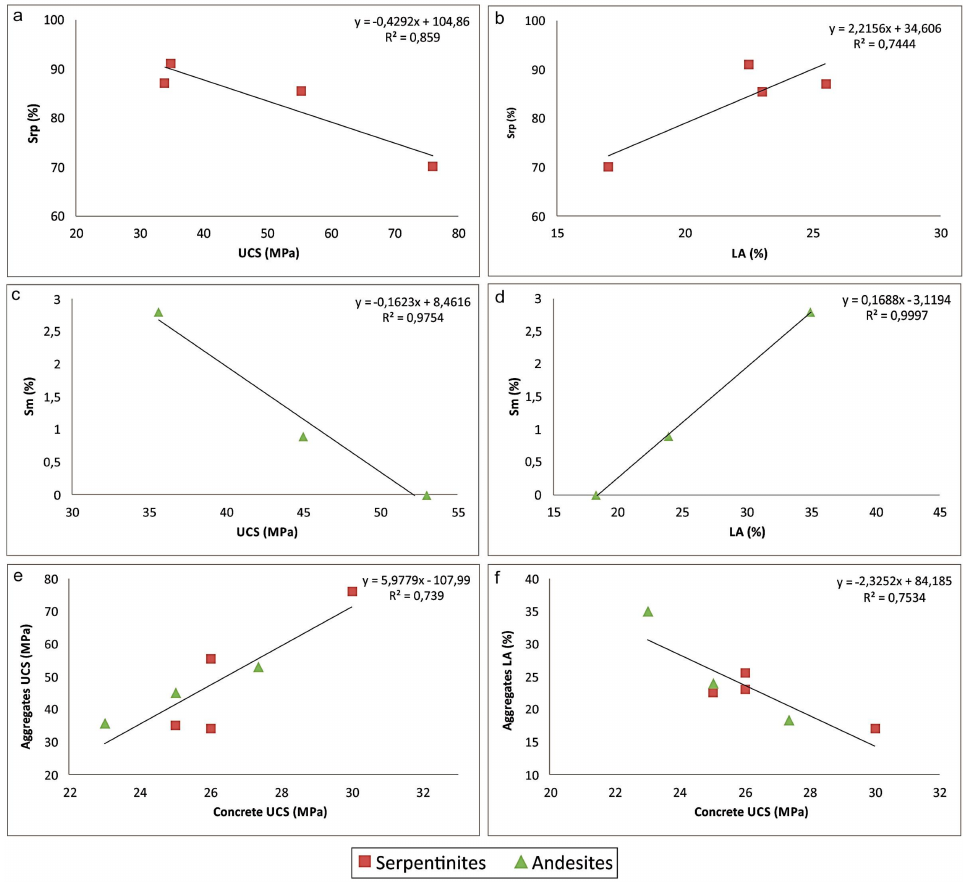
Figure 9. Serpentine abundance (srp) in the serpentinite aggregates plotted against their uniaxial compressive strength ( a ) and their Los Angeles values ( b ); smectite abundance in the andesite aggregates plotted against their uniaxial compressive strength ( c ) and their Los Angeles values ( d ); uniaxial compressive strength of the concrete specimens plotted against uniaxial compressive strength ( e ) and Los Angeles values ( f ) of their